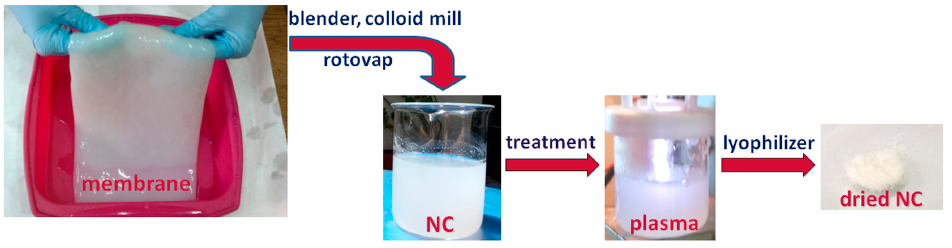
Figure 1. Schematic representation of defibrillation and plasma treatment of nanocellulose.